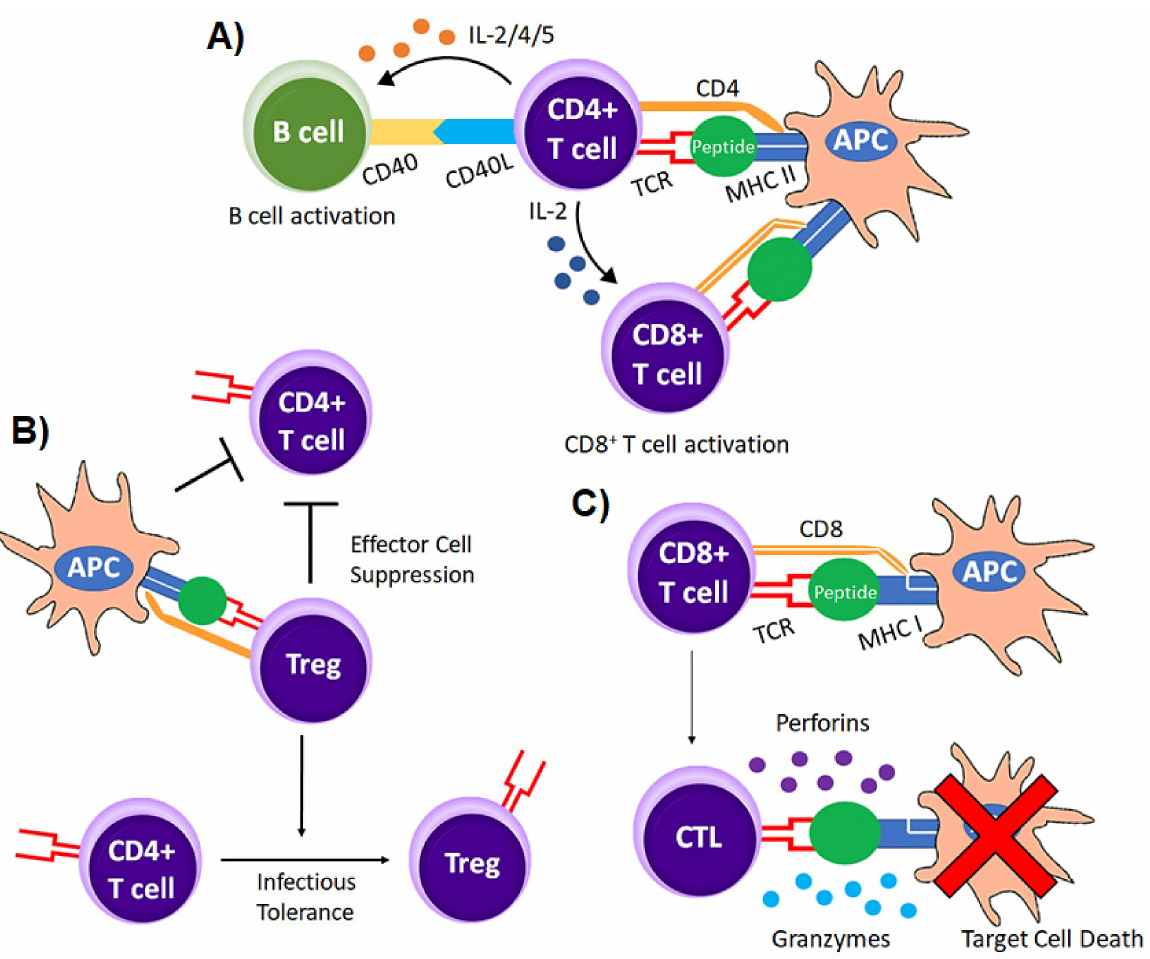
Figure 3. T cell subtypes. T cells are generally classified based on their cytokine production profiles and effector function. They are activated or respond to APCs or targets differently based on how antigen is presented and the other signals (cytokines, chemokines, and cell surface molecules) they receive. ( A ) CD8 + effector and CD4 + helper T cells each possess unique TCRs that interact with MHC class I or MHC class II molecules respectively on APC or target cells. In this panel, CD4 + T cells are providing help to CD8 + T cells in the form of IL-2 and other signals not shown. ( B ) CD4 + regulatory T cells suppress immune responses by inhibiting T activation and function. ( C ) CD8 + T cells are mainly effector T cells capable of inducing target cell